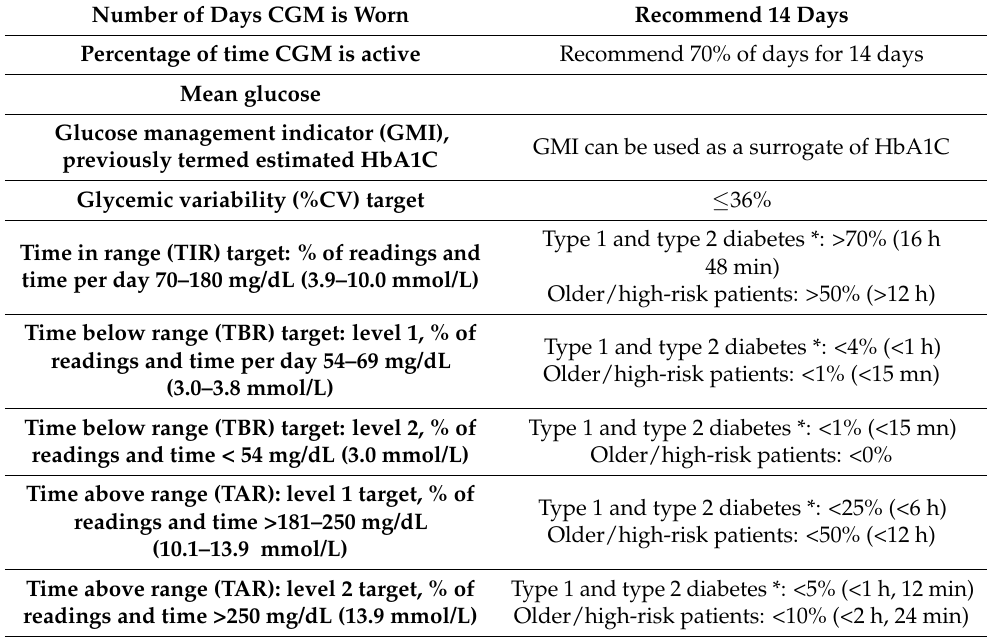
Table 2. The 10 core CGM metrics. Number of Days CGM is Worn Recommend 14